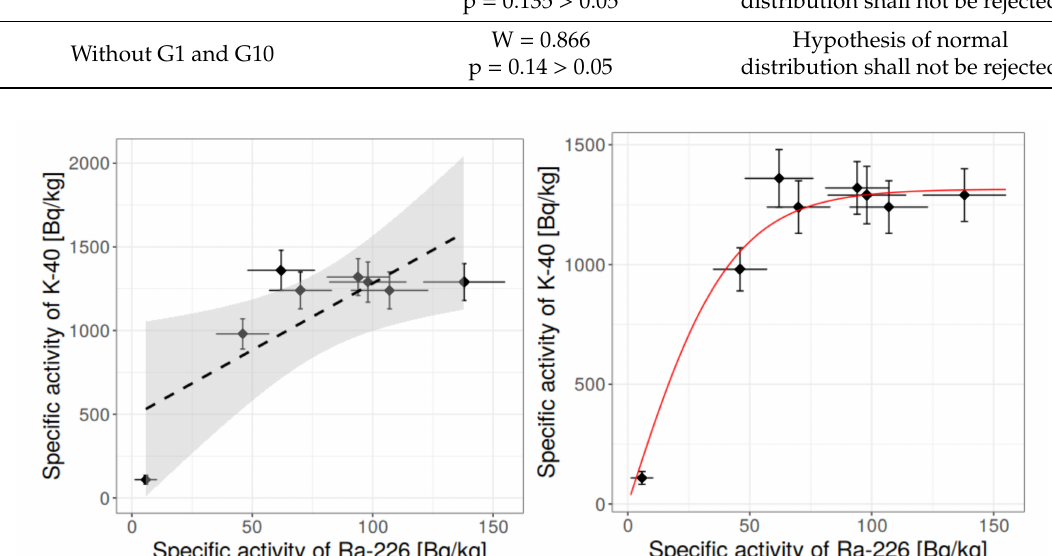
Figure 14. Relationship between specific activity concentration of 40 K and 226 Ra in measured granite samples, taking into account the rejection of outliers. Left: linear model with 95% confidence corridor, right: more realistic sigmoidal model (saturation for high concentration of radium). Determination factor: R 2 =